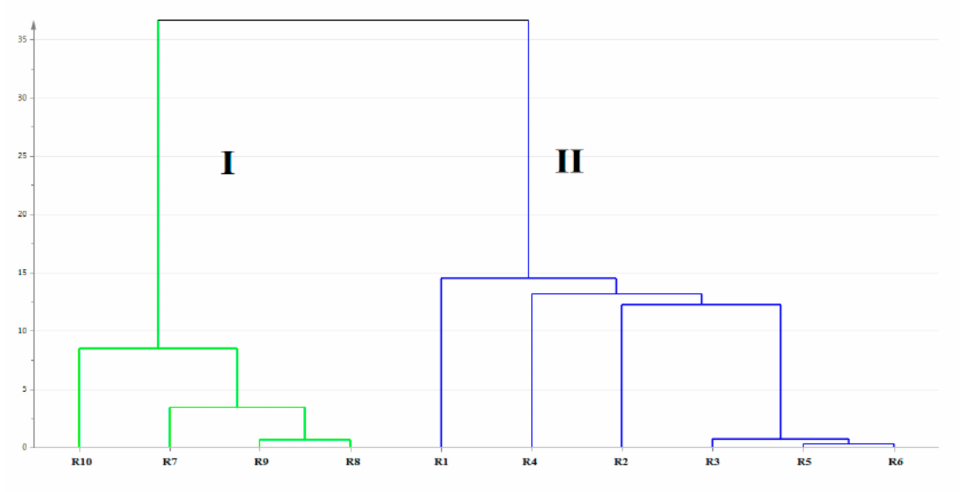
Figure 6. Hierarchical cluster analysis (HCA) dendrograms of di ff erent samples of Lonicera japonica Thunb. I Group 1; II Group